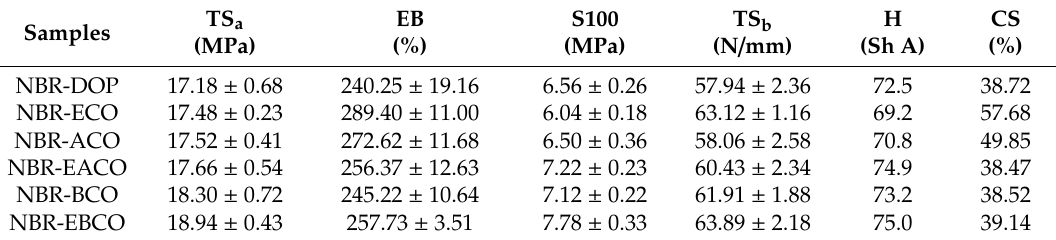
Table 3. Physical and mechanical properties of NBR